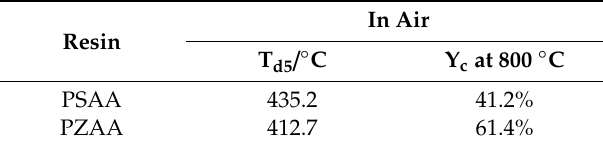
Table 2. TGA analysis results of BA and BSA in